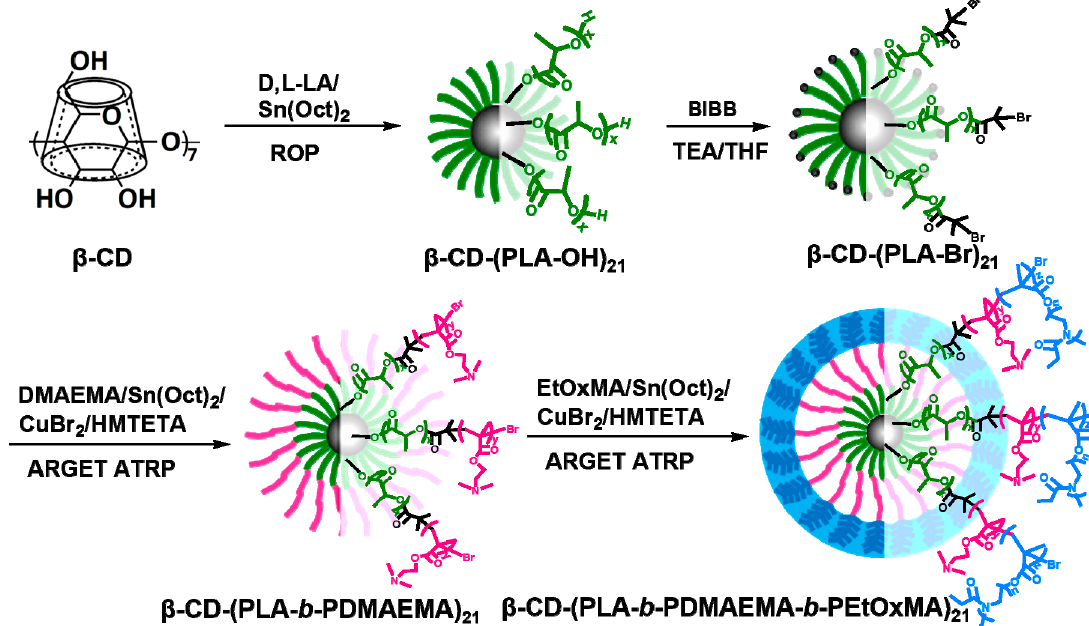
Scheme 2. Schematic illustration of the synthesis of β -CD-(PLA- b -PDMAEMA- b -PEtOxMA) 21 .